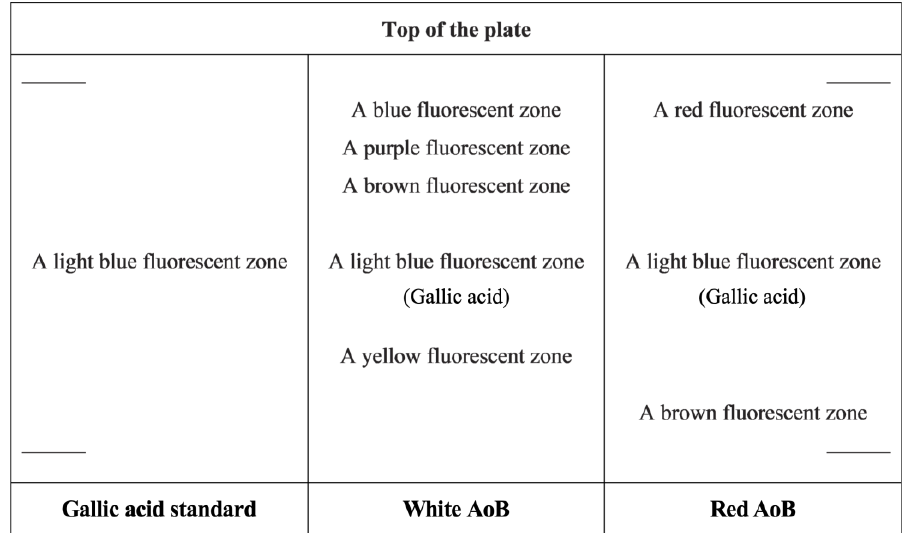
Figure 4. White and red AoB TLC fingerprint schemes.